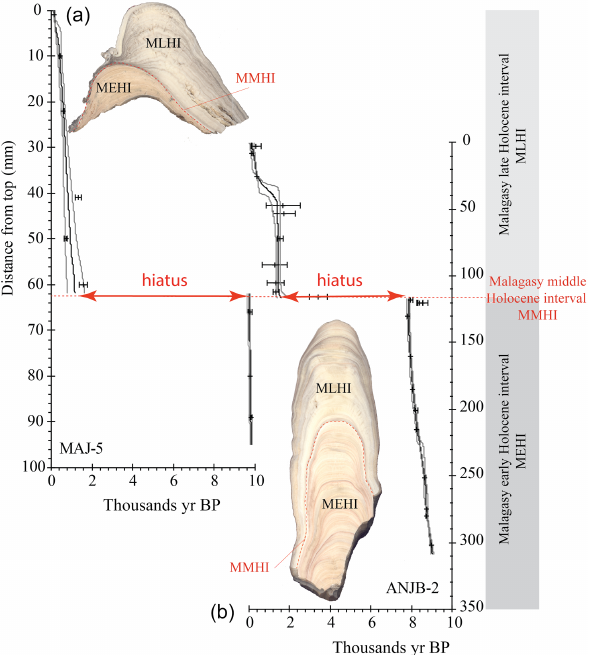
Figure 2. Age model of Stalagmites MAJ-5 (a) and ANJB-2 (b) using the StalAge1.0 algorithm of Scholz and Hoffman (2011) and Scholz et al. (2012). Scanned images of the two samples are shown for reference and to indicate the three distinct Holocene